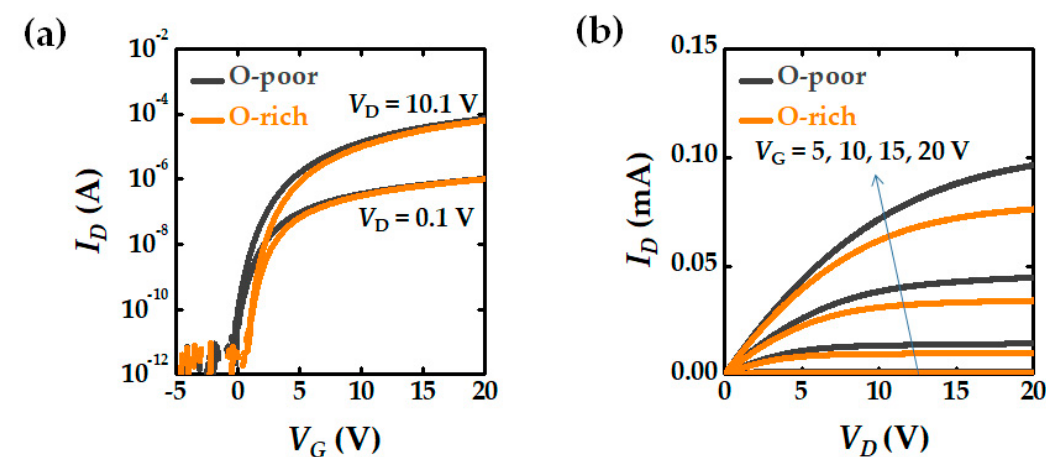
Figure 2. Current-voltage characteristics of IGZO TFT device: ( a ) Transfer characteristics of O-poor and O-rich devices; ( b ) Output characteristics of O-poor and O-rich devices.